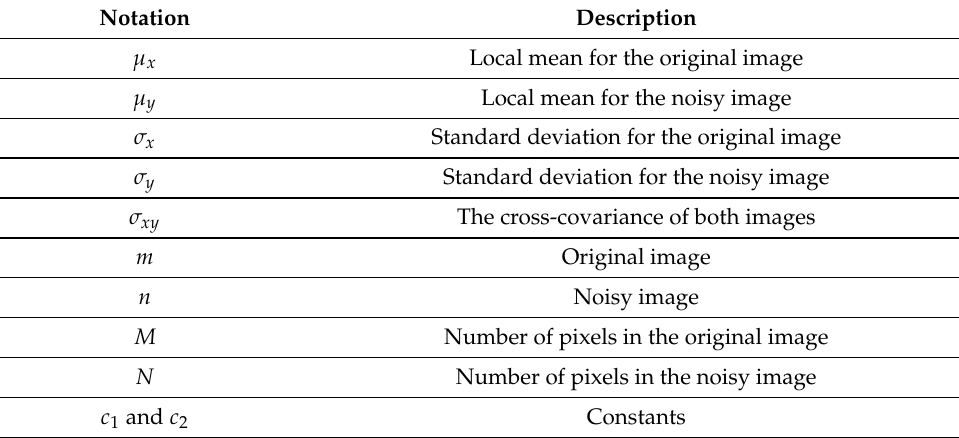
Table 5. Mathematical notation.